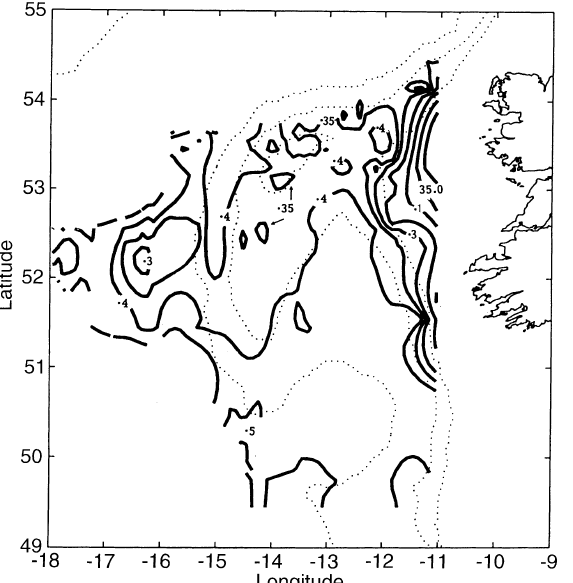
Fig. 2. Surface salinity map for July 1995. Only the 35 contour and the decimal places of other values are annotated. The contour interval is 0.1 with additionally the 35.35 contour added. The 200, 500 and 2000-m isobaths are also marked by the light contour lines